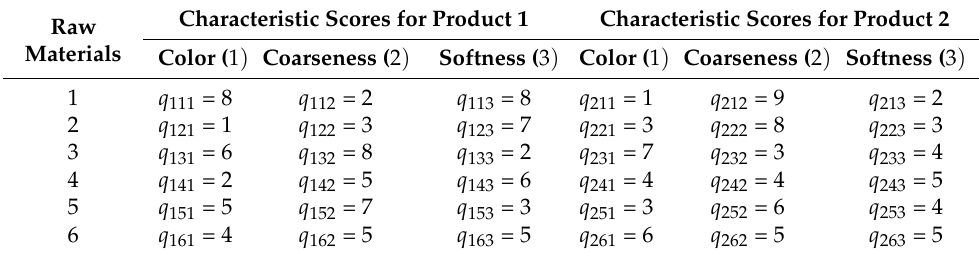
Table 3. Scores for the raw material characteristics.